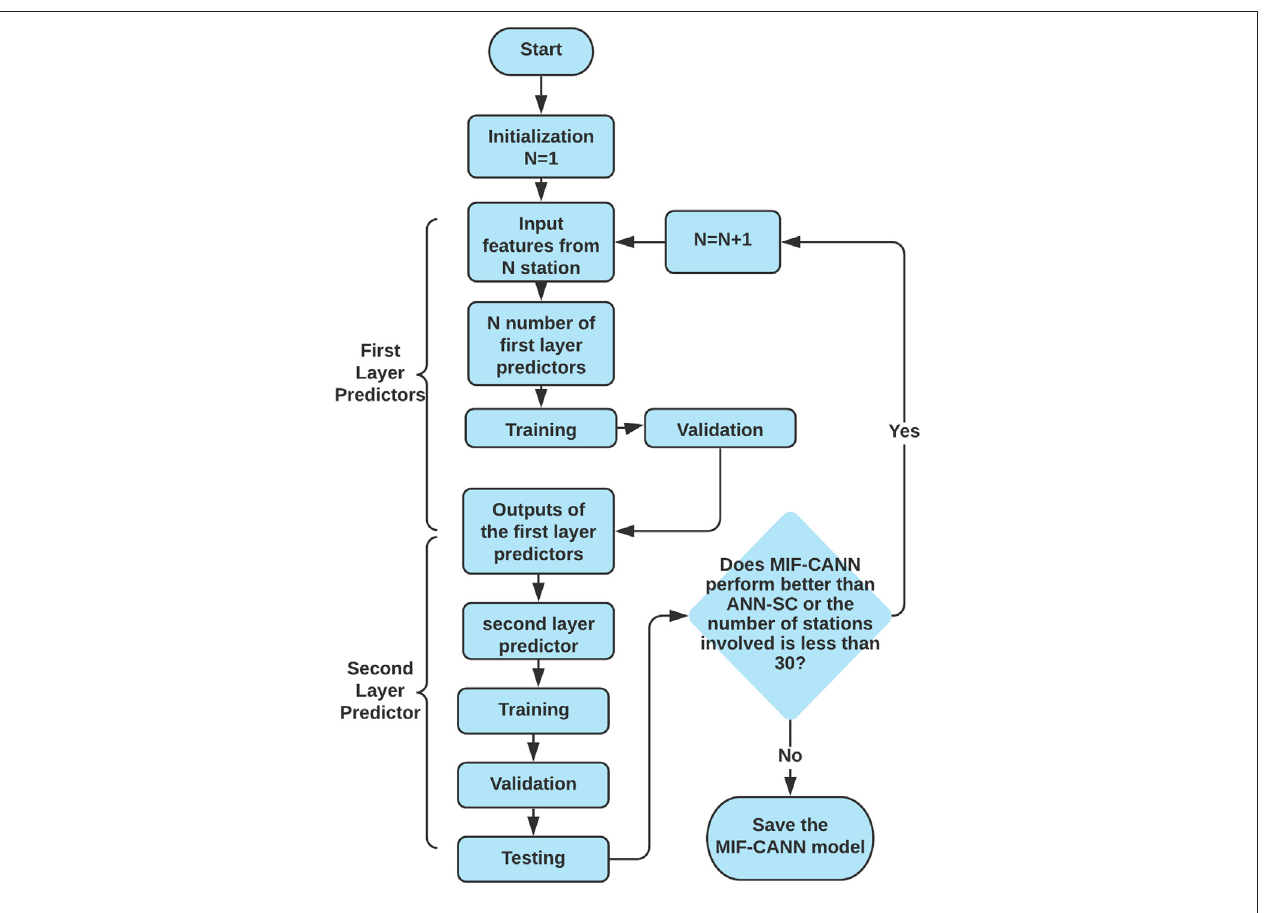
FIGURE 5 | Flowchart of the proposed MIF-CANN model.